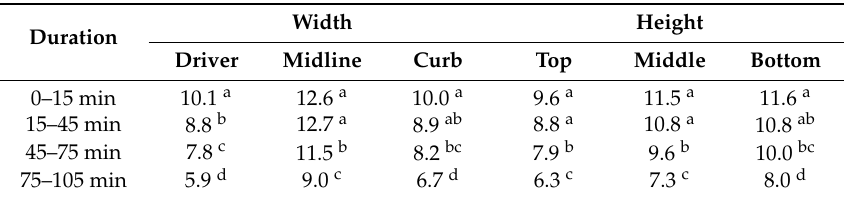
Table 7. Effect of trip duration on elevated temperature above ambient ( ∆ t, ◦ C) at measured locations across the width and height of the trailer with double boards ( n =